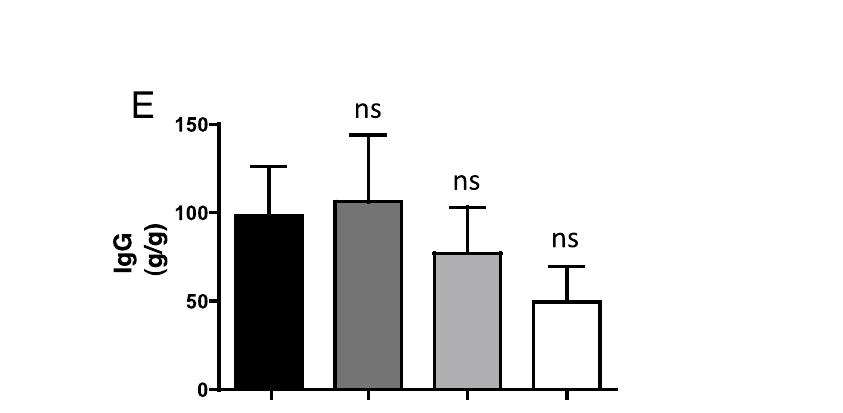
PLOS ONE | www.plosone.org